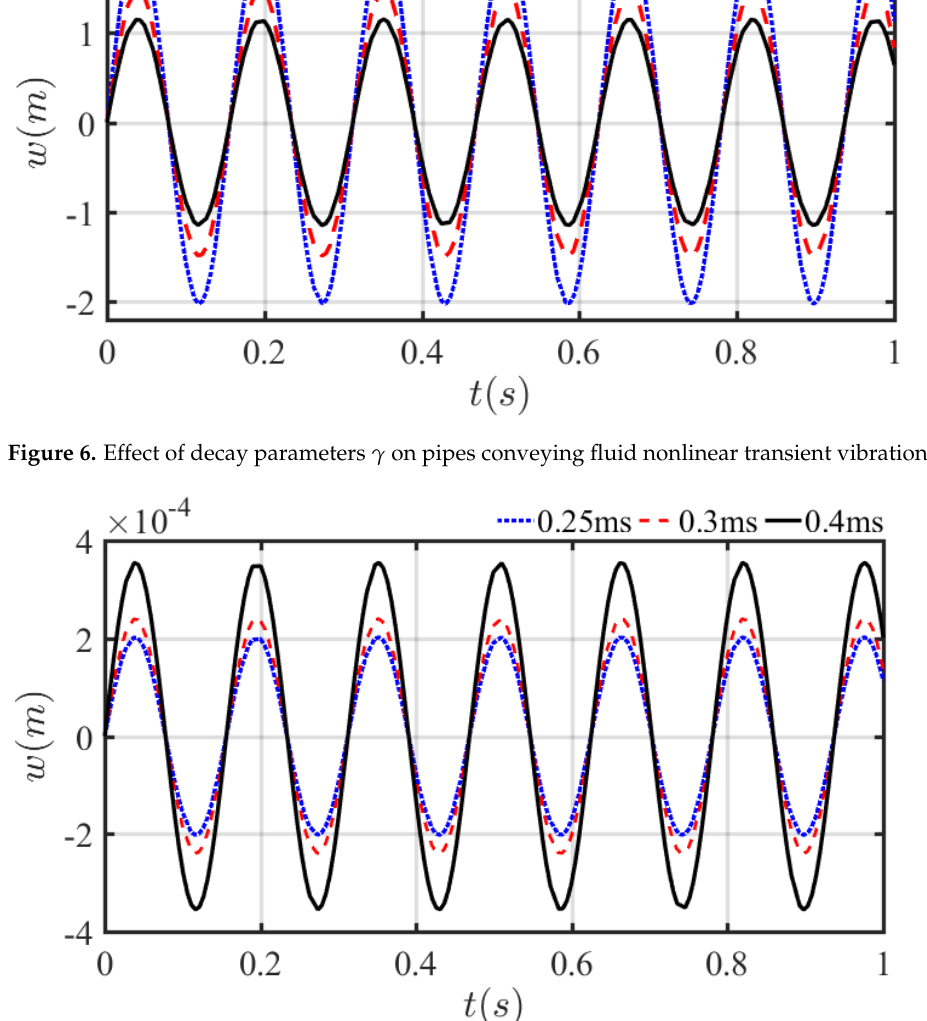
t on pipes conveying fluid nonlinear transient vibration. Figure 7. Effect of explosion time t p on pipes conveying fluid nonlinear transient Figure 7. Effect of explosion time p